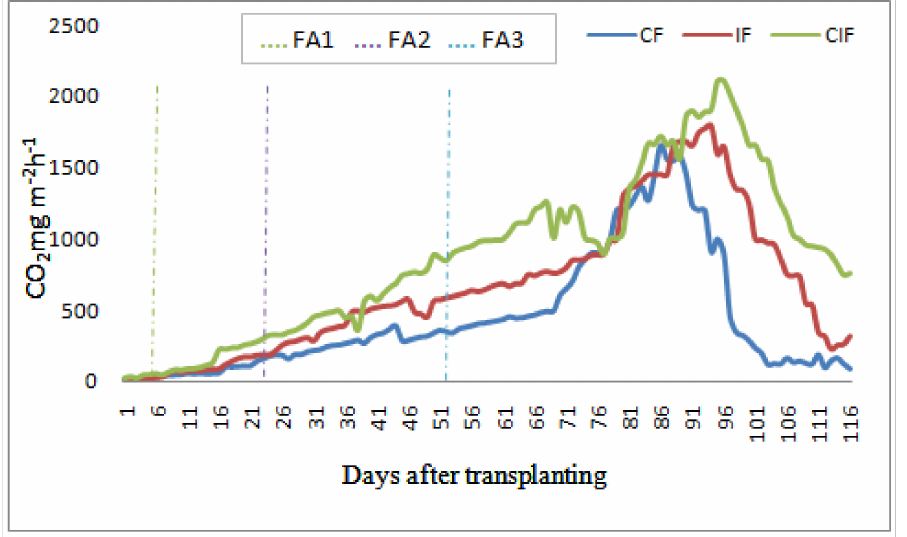
Figure 9. CO 2 emission from rice fields (dry